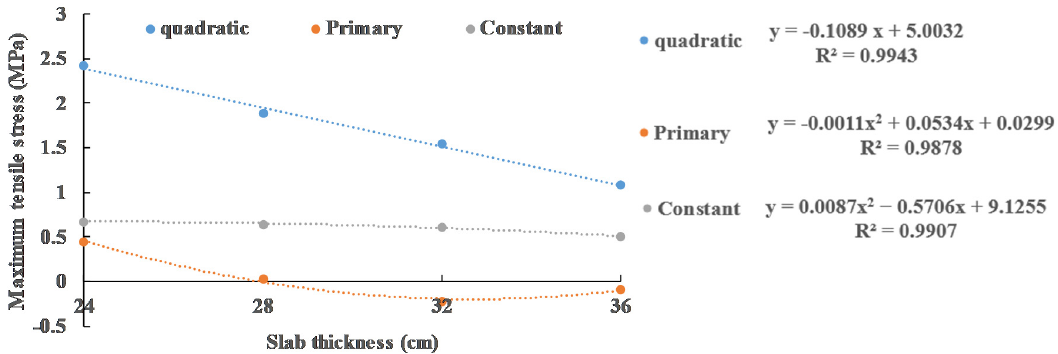
Figure 17. Regression relationship between maximum tensile stress and slab thickness under 0.6 MPa load.